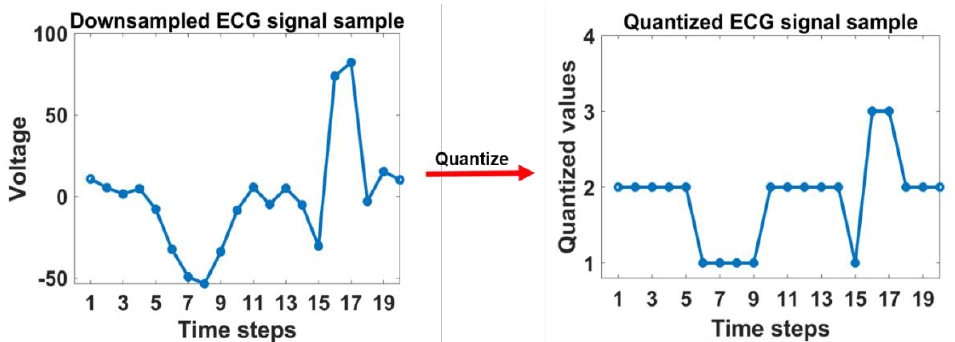
Figure 1. Downsampled ECG signal ( left ) and its quantized ECG signal ( right ). The ECG signal was downsampled to 50 Hz and the quantization level was 4 for convenience.